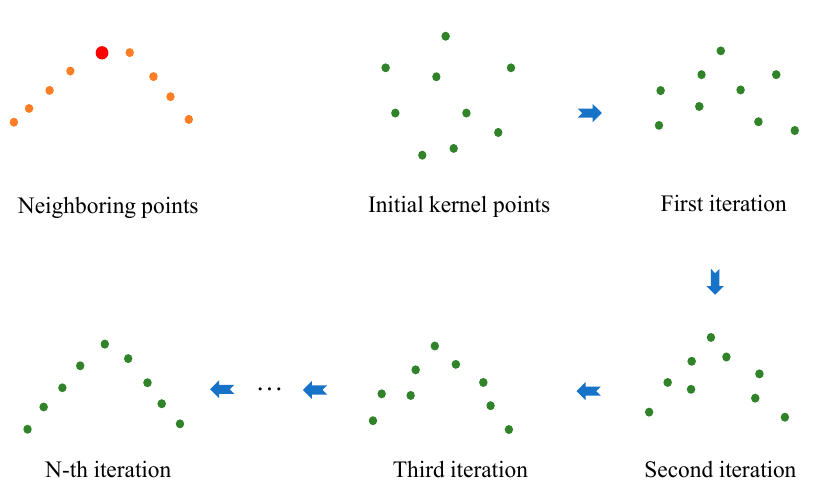
Figure 2. Illustration of the training process of our structure-aware convolution (SAC). The kernel points’ coordinates are randomly initialized using a uniform distribution. With training iteration, the kernel points’ coordinates are gradually adjusted so that they can be well matched with one kind of geometric structure formed by the neighboring points in real situations. The learned kernels can then be used to capture the interested structures in 3D point clouds during the test phase.